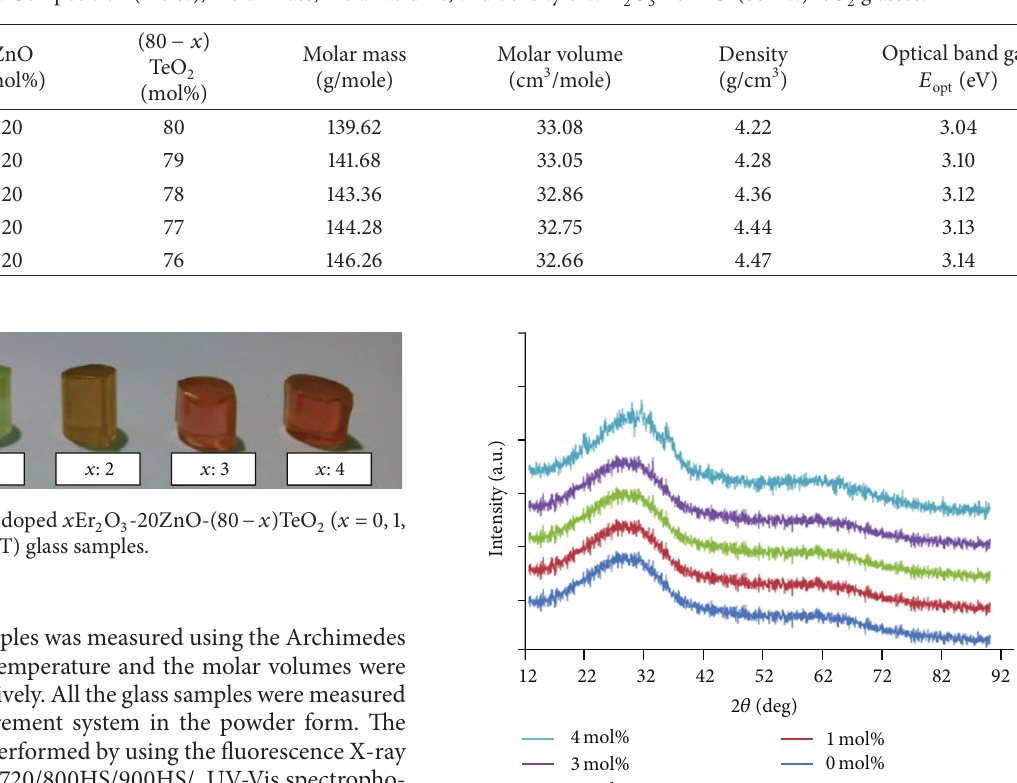
Table 1: Composition (mol%), molar mass, molar volume, and density of 𝑥 Er